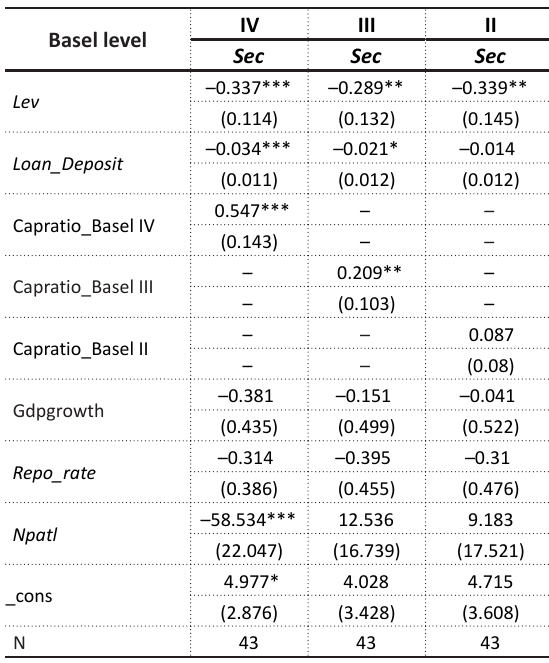
Table 4. Results of capital requirements